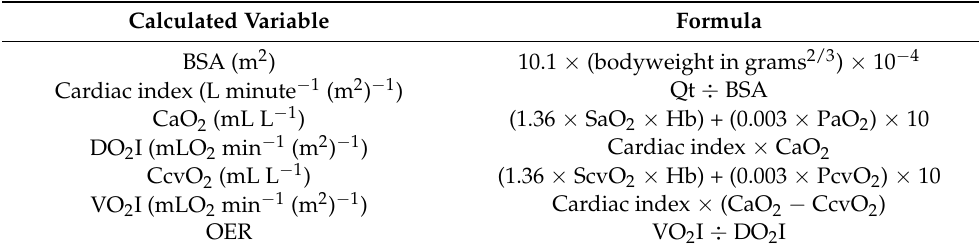
Table 1. Calculation of oxygen extraction ratio